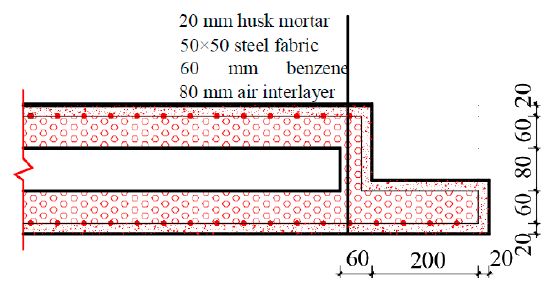
Figure 1. The wallboard products.